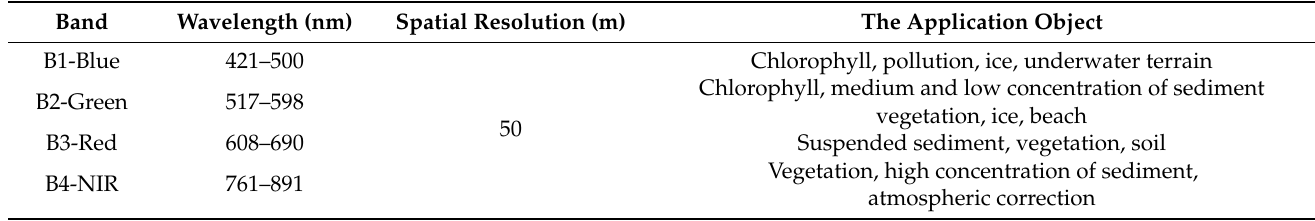
Table 2. The parameters of CZI sensor and information about the